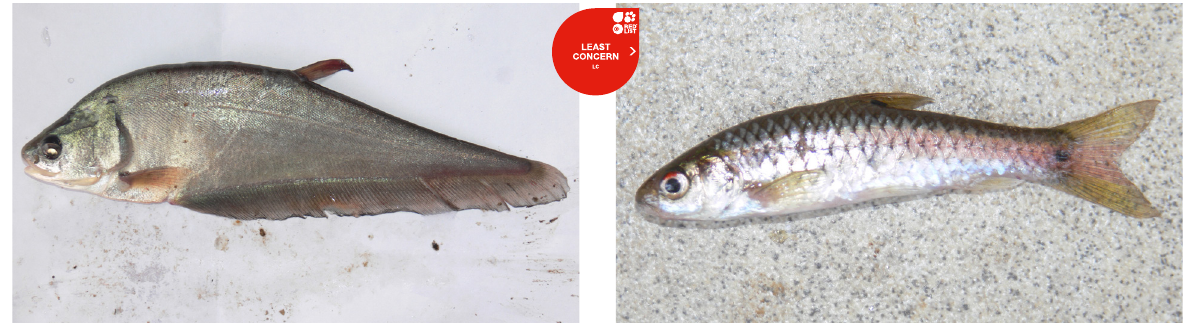
Image 1. Notopterus notopterus Image 2. Puntius